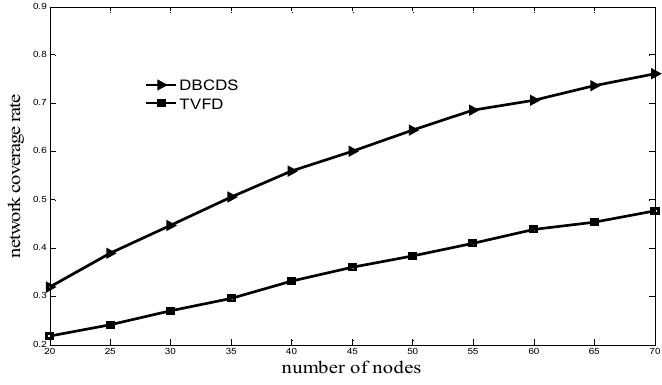
Figure 6. Comparison of network coverage rate.